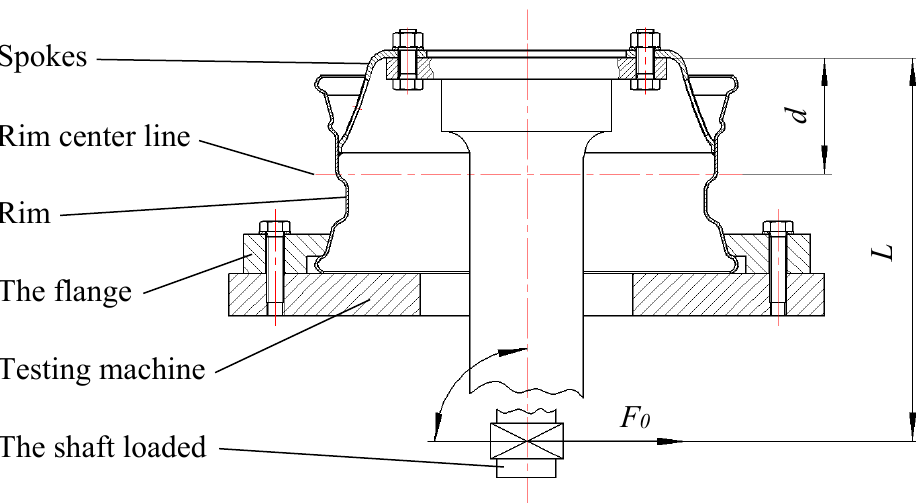
Figure 9. Schematic diagram of dynamic bending fatigue test.